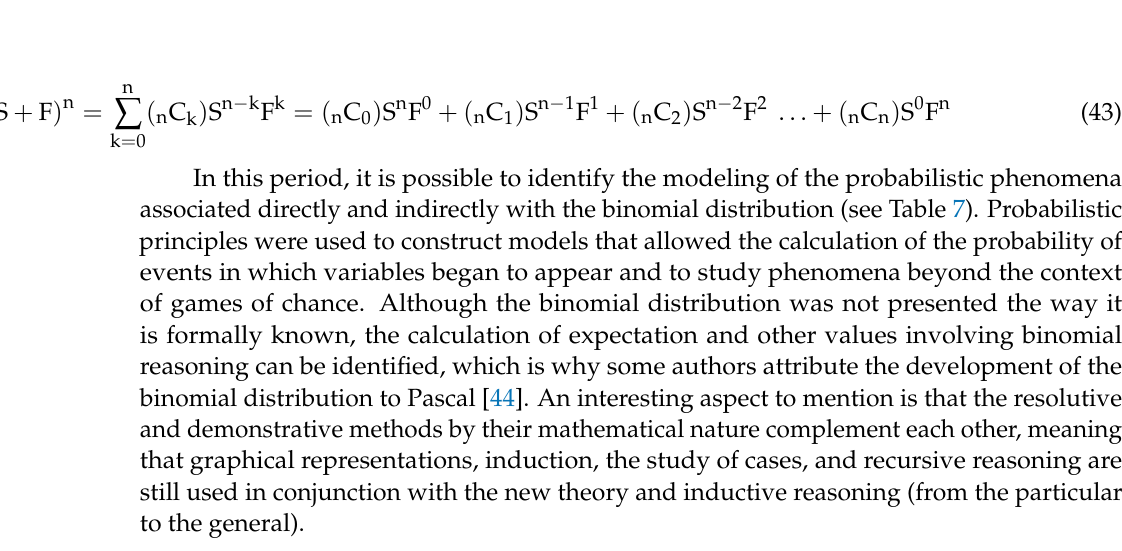
Table 7. Historical problem situations (17th century–18th